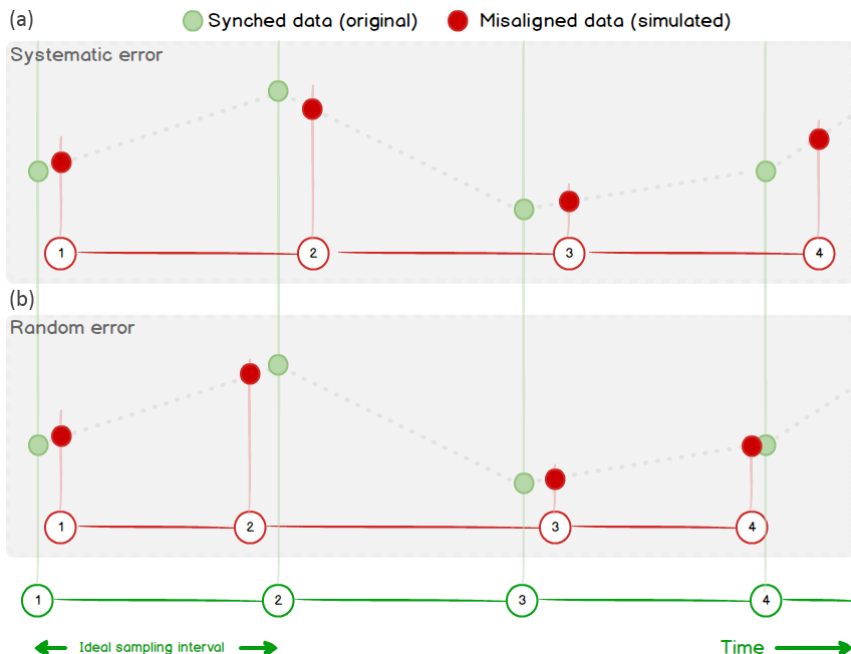
Figure 3. Sketch of the timing error simulation via linear interpolation. Green dots represent original T s data points, equally spaced at the prescribed (nominal) time steps. In (b) , RTEs are simulated as time steps randomly varying around the nominal value. In (a) , STEs are simulated as a time step larger than the nominal one, whereby the difference between the assigned and correct timestamps always increase in